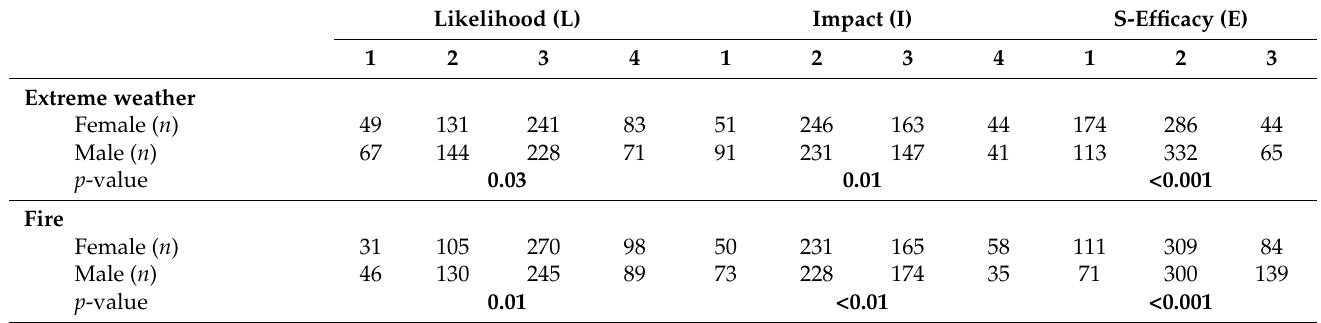
Table 4. Absolute counts of respondents in the perceived likelihood (from 1 = highly unlikely to 4 = highly likely), impact (from 1 = very low to 4 = very high) and self-efficacy (1 = I do not know what to do; 2 = I fairly know what to do; 3 = I know what to do) for extreme weather conditions, fire, earthquake, hazardous material accidents and terrorist attack. p -values of the two-sided Wilcoxon rank sum test for likelihood and impact and Chi-Square test for self-efficacy. The significant p -value is in